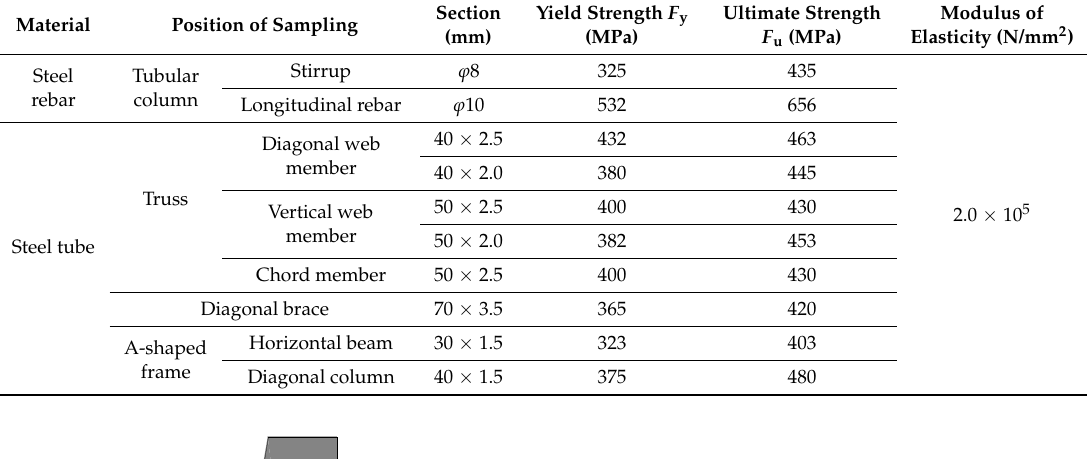
Table 2. Material properties of steels used in the test specimen.